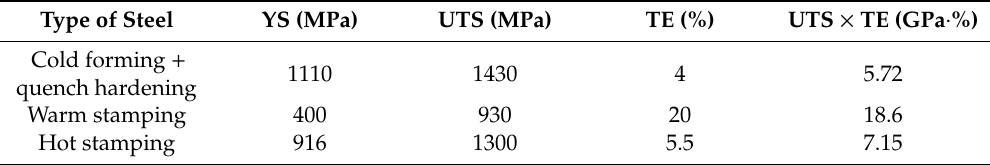
Table 1. Mechanical properties of MSW 1200 steel after di ff erent processes